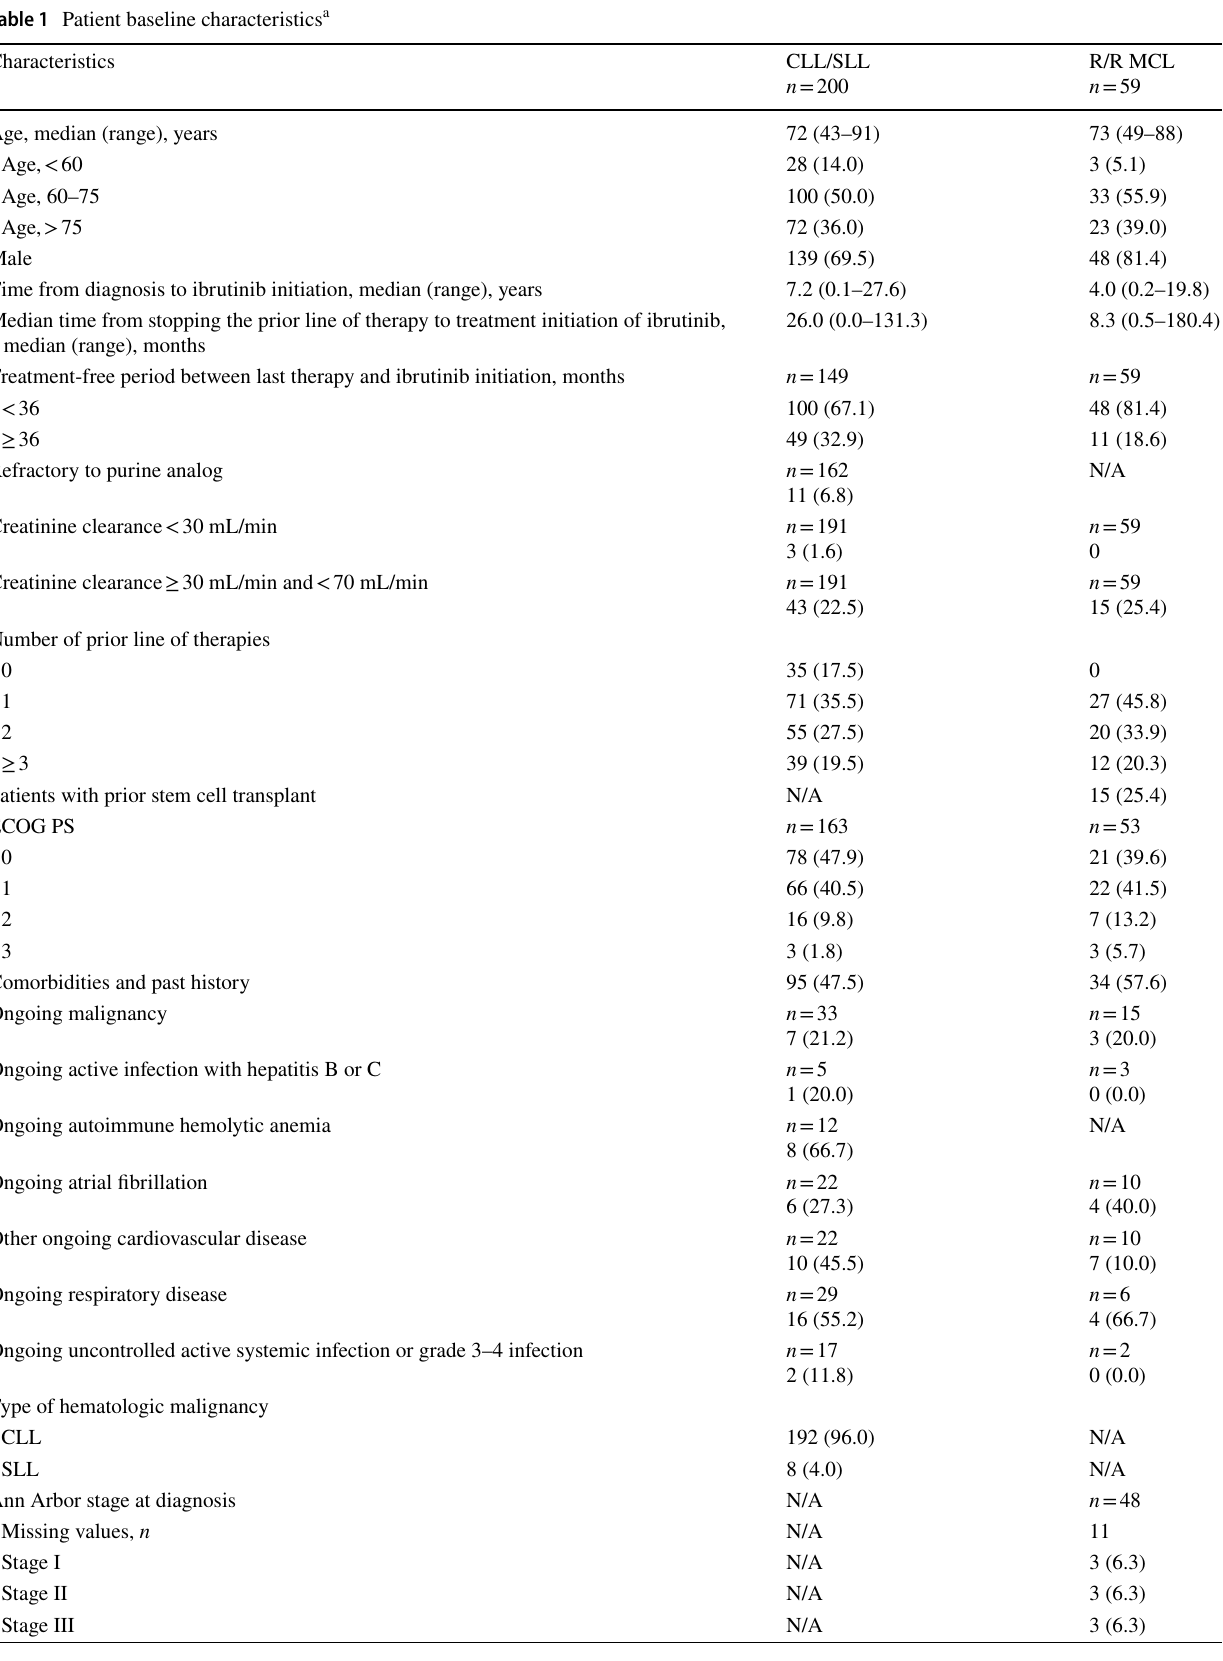
Table 1 Patient baseline characteristics